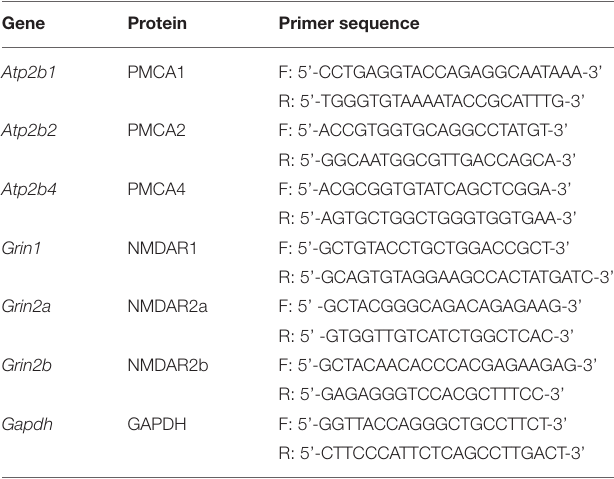
TABLE 1 | Primers used in the real-time